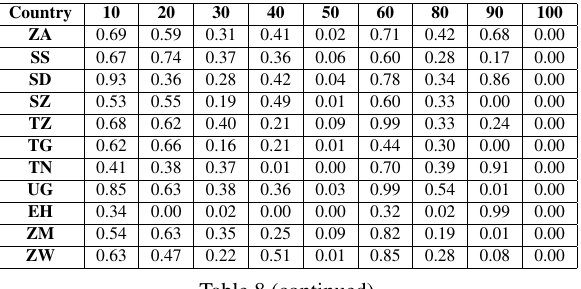
Table 9. UA in African country (Class labels corresponding to the class code from the header can be seen in Table 2)